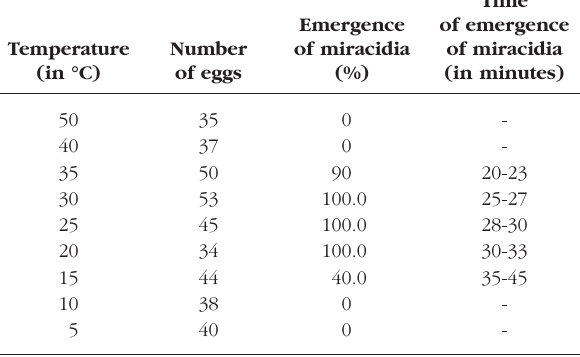
Table I. – The effect of temperatures on the process of hatching of D. loossi miracidia from